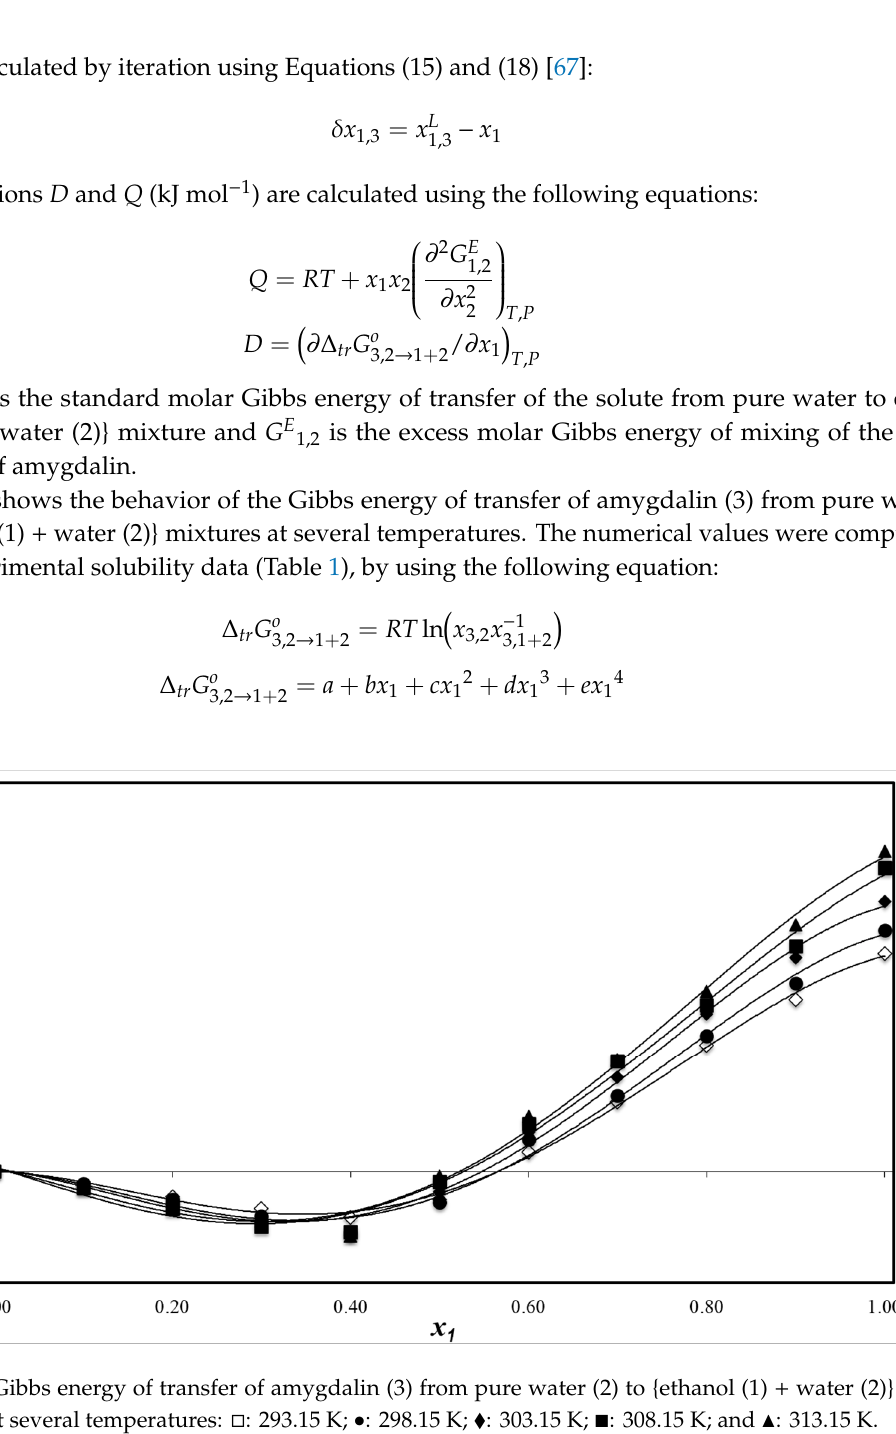
308.15, and 313.15